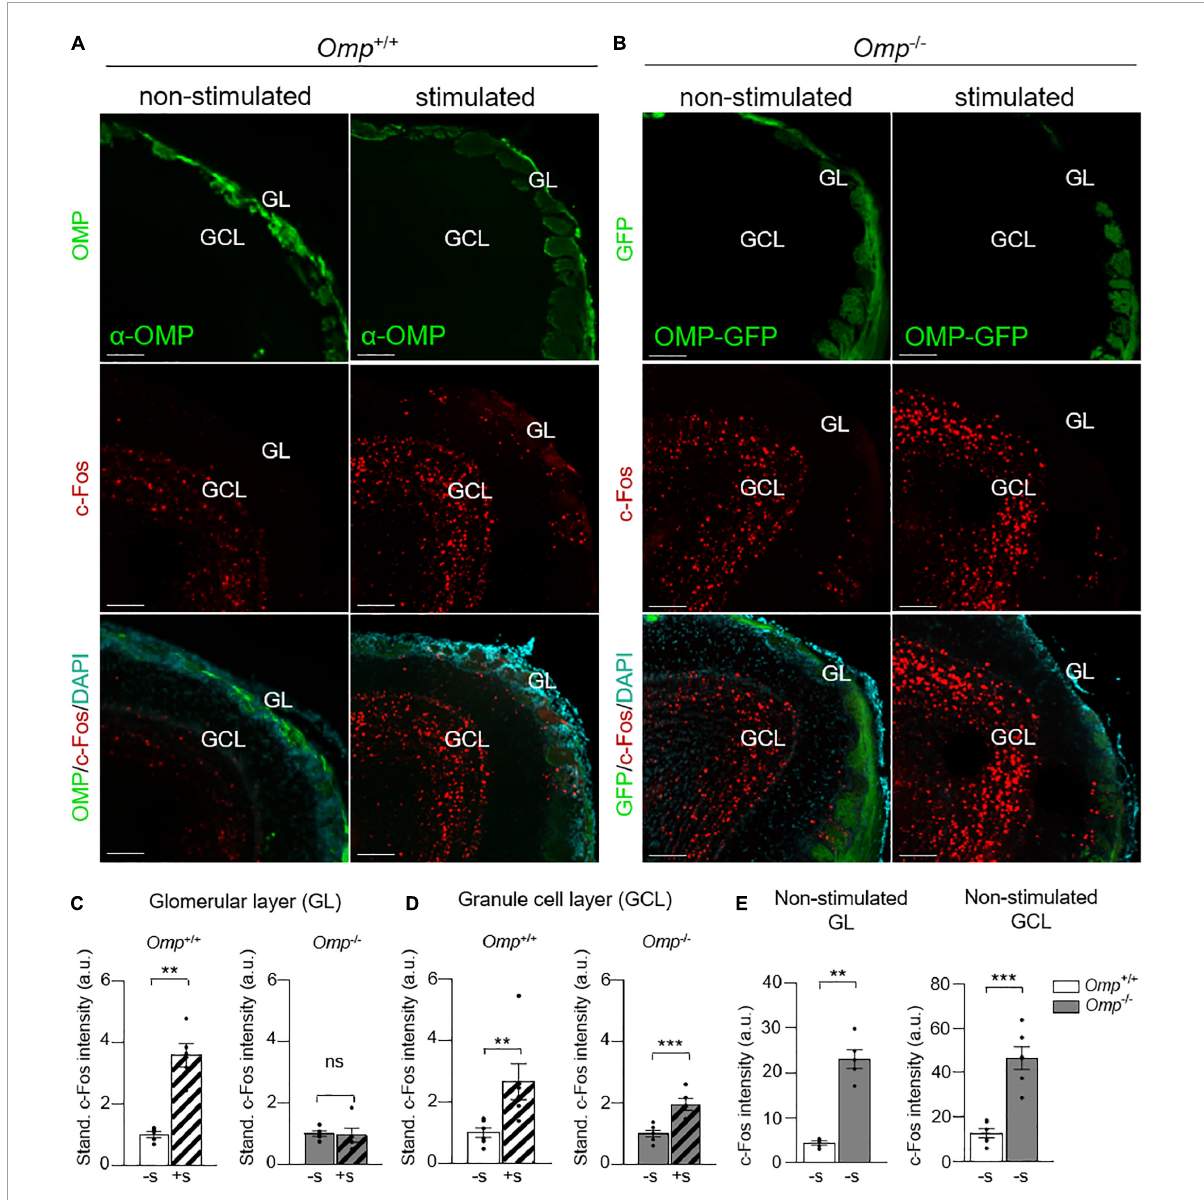
FIGURE3 Functional integration of odorants in OMP null mice. (A) c-Fos immunostainings in the olfactory bulb of Omp + / + (A) and Omp − / − mice (B) with or without odorant stimulation (here, Cinnamon). In green, the staining of mature olfactory sensory neurons. In blue, the nuclei stained with DAPI. GL, glomerular layer; GLC, granule cell layer. Scale bars: 100 µ m. (C) In the glomerular layer, a significant increase of the c-Fos staining intensity after odorant stimulation (+S; dashed bars) is only observed in Omp + / + . (D) In the granule cell layer, a significant increase of the c-Fos staining intensity is observed in both genotypes after odorant stimulation. Dot-plots representation in panels (C,D) are standardized to the non-stimulated condition (–S; solid bars). (E) An increased basal bulbar activity is observed in Omp − / − mice as shown by the intensity of c-Fos positive cells both in the GL and GCL. N = 7–9 animals were used per genotype and condition. Values obtained are represented as mean ± SEM. For comparisons between conditions and between genotypes, one-tailed or two-tailed Student’s t -tests/Wilcoxon w -tests are respectively used, ** p < 0.01, *** p < 0.001 and ns for